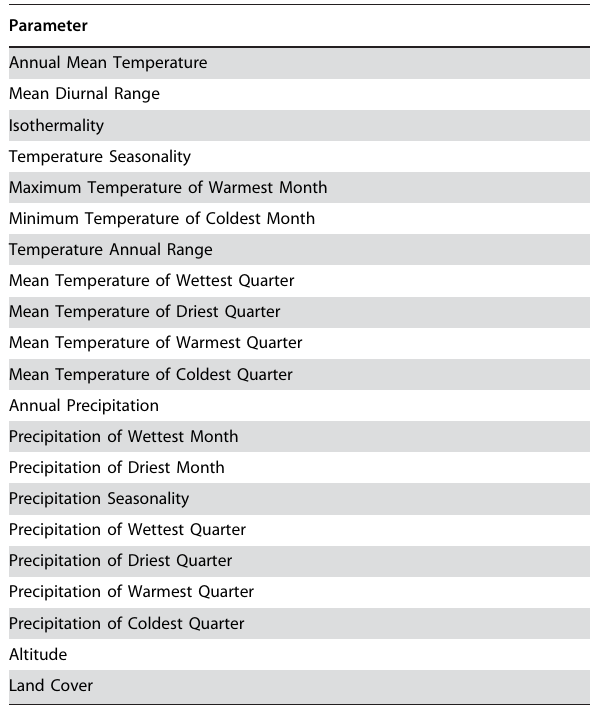
Table 1. Environmental Parameters Used in Niche Modelling ... ... ... .... ... ... .... ... ... .... ... ... .... ... ... .... ... ... .... ... ...